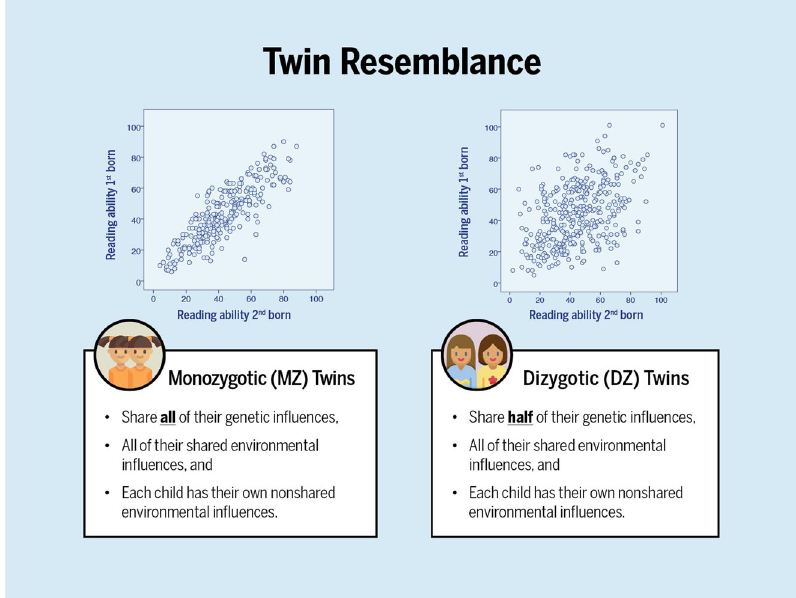
Fig. 3 The logic behind twin research. The scatter plots depict how much the two types of (reared-together) twins resemble their co-twin on reading ability. Each dot represents the reading scores of both children within a pair. It can be seen that monozygotic twins are much more alike. From this, it can be concluded that differences between children are largely due to genetic differences. The data come from van Bergen et al. 34 and represent word-reading fl uency test scores in Grade 2 of twin pairs with complete data. The score is the number of words read correctly within 1 min. In this sample, the monozygotic and dizygotic twin correlations were 0.84 and 0.46, respectively, which yield estimates using the Falconer formulas 67 of A = 0.76, C = 0.08, and E = 0.16 (see Fig. 4). Figure by ref. 66 available at https://bit.ly/3k4w2Ji under a CC BY 4.0